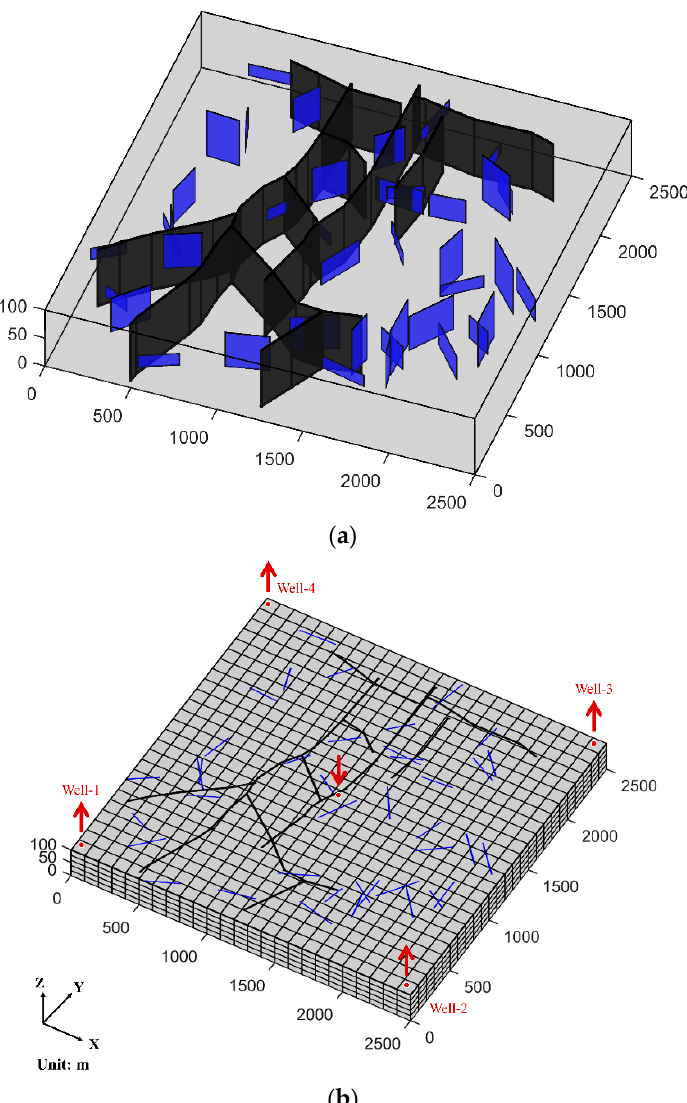
Figure 14. ( a ) Three-dimensional view of main fractures and medium-scale fractures; ( b ) The matrix grids of the reservoir and the position of each fracture and each well.